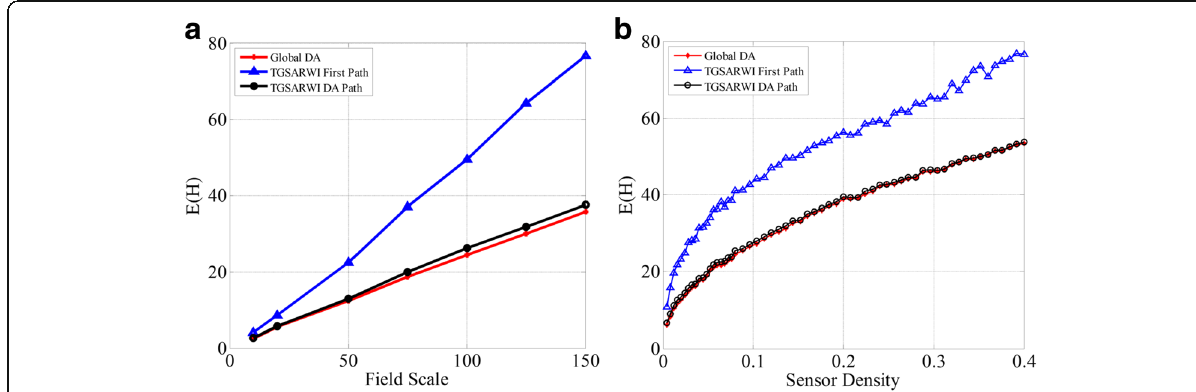
Fig. 9 Precision comparison of Global DA, TGSARWI DA, and the first path obtained by TGSARWI in various field scales and sensor densities, where a shows the exposure trends of three paths with the changes of field scale, and b shows the exposure trends of three paths with the changes of sensor